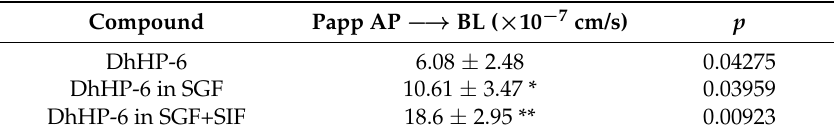
Table 1. Permeability of digestion products in Caco-2 cells. The results are presented as mean ±